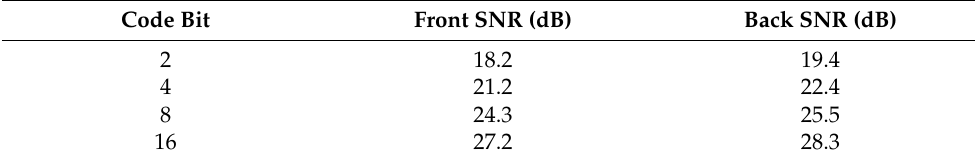
Table 3. The SNR of Golay code pair of different lengths from the FE and BE at 30 kHz.